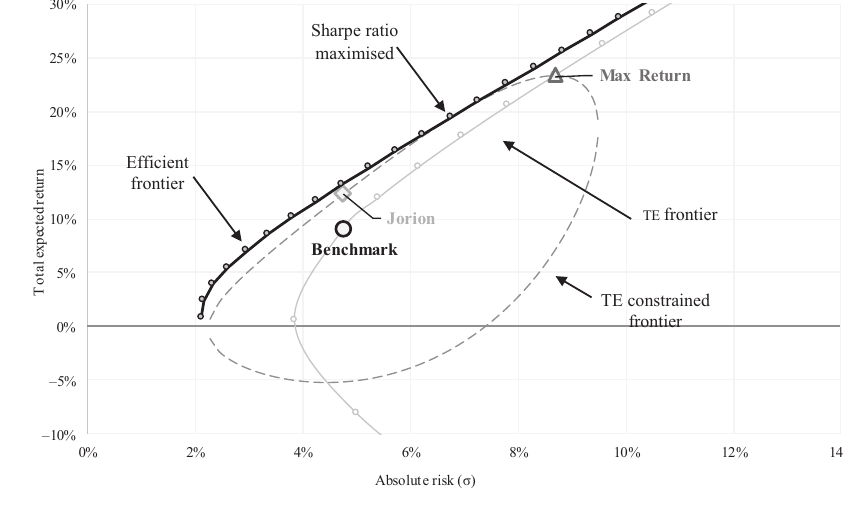
Figure 7. Test 1, low volatility,